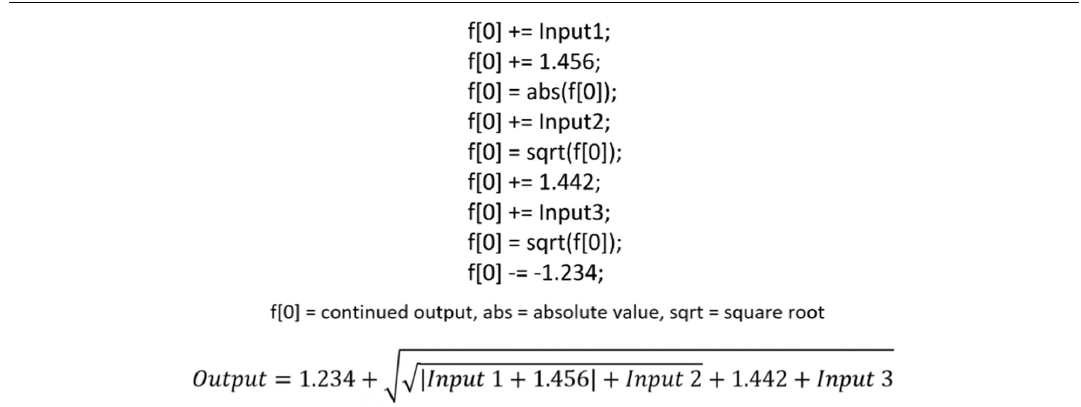
Algorithm 1. Example of simple LGP (Linear Genetic Programming), with corresponding algebraic structure.